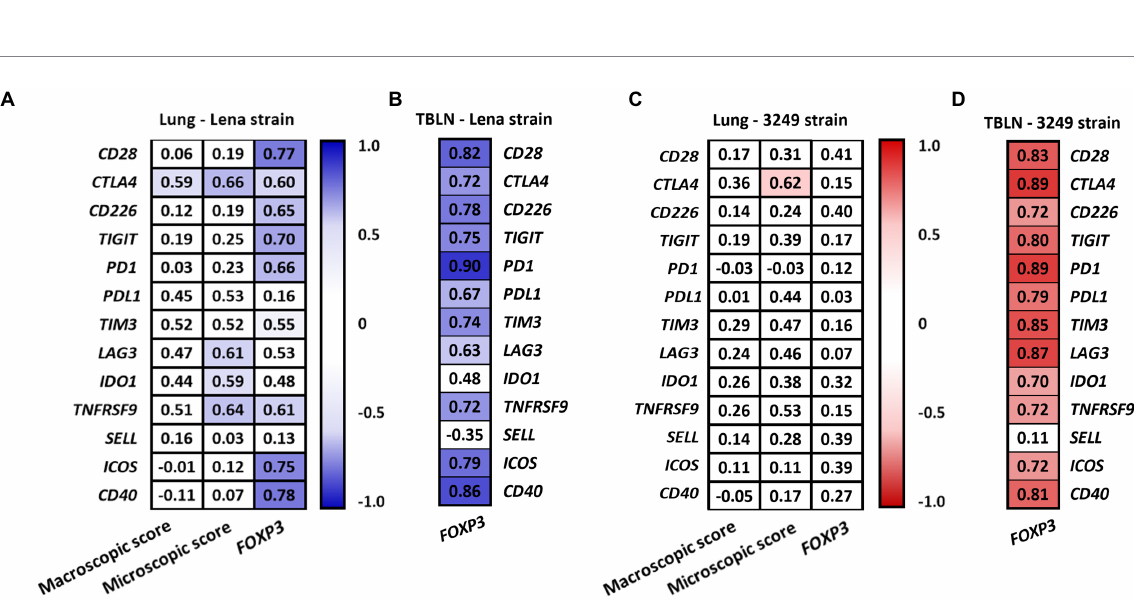
FIGURE 9 Correlation found between the expression of immune checkpoints, the macroscopic and the microscopic score and the expression of FOXP3 in lung from Lena- (A) and 3249-infected group (C). Correlation found between the expression of immune checkpoints and the expression of FOXP3 in the tracheobronchial lymph node (TBLN) from Lena- (B) and 3249-infected group (D). Significant correlations for Lena and 3249 strains are represented with blue and red color, respectively ( ρ > 0.55, p ≤ 0.05).